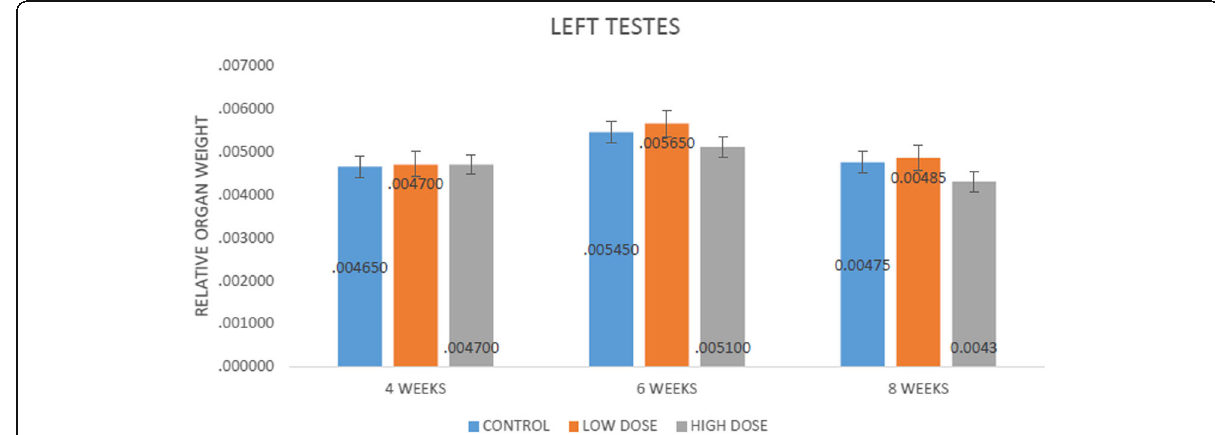
Fig. 2 Effect of administration of aqueous root extract of Chrysophyllum albidum on the weight of the left testes of the experimental rats. n =